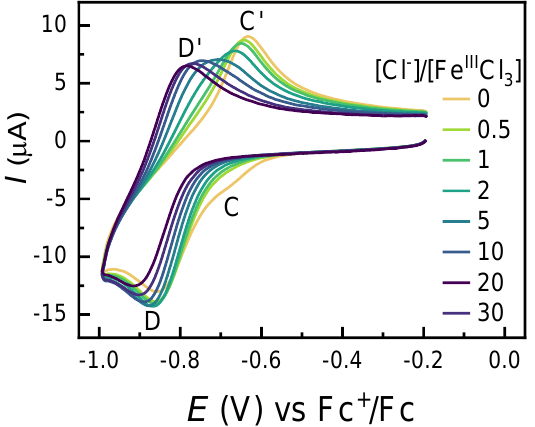
Figure 4. Cyclic voltammetry of 1 mM Fe III L(Cl) in DMF + 0.1 M Et 4 NBF 4 recorded on a GC electrode at v = 0.2 V/s and T = 25 °C, before and after addition of different amounts of Et 4 NCl.